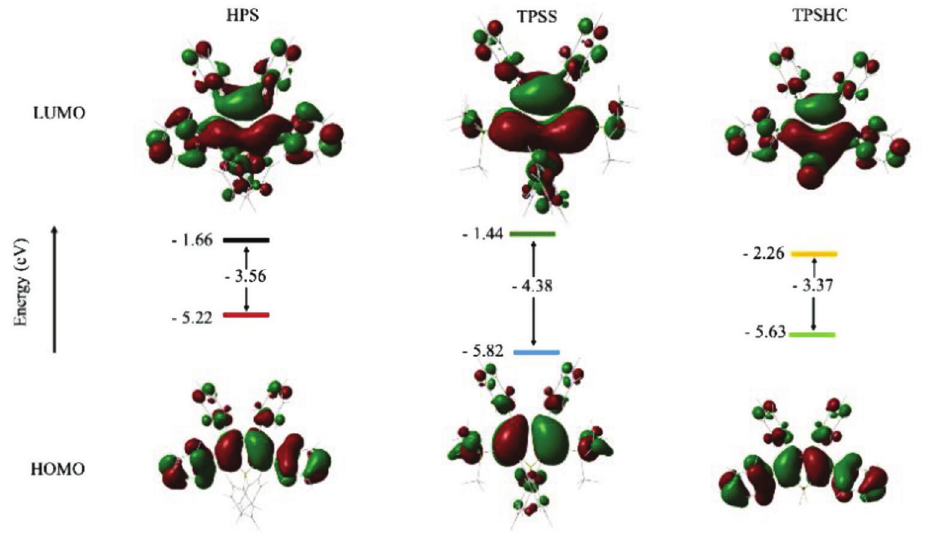
Figure 4: Molecular orbitals distribution of HPS, TPSS, and